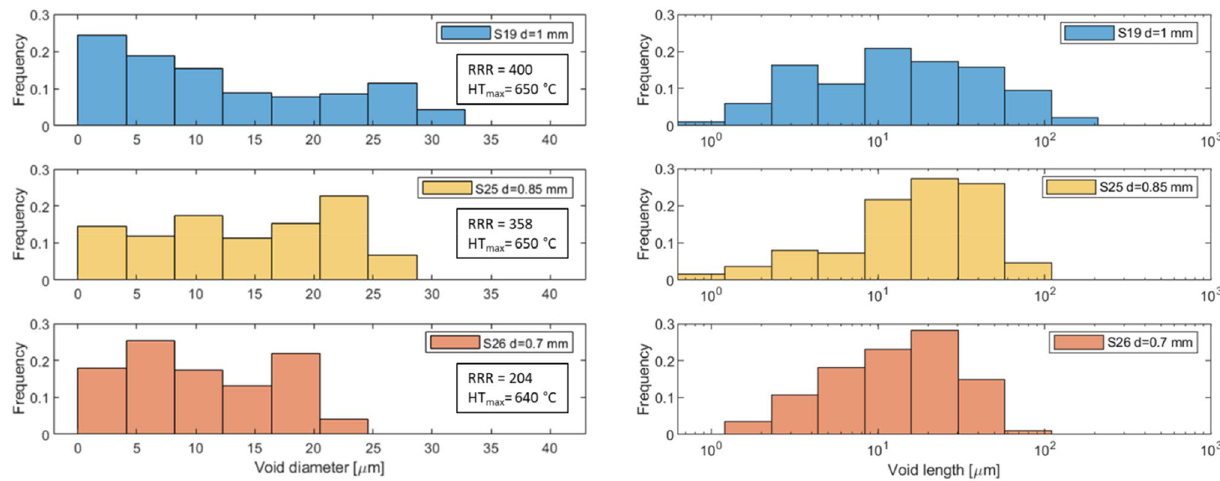
Figure 9. Frequency of the sub-elements voids as function of diameter (left) and length (right) for samples S19, S25 and